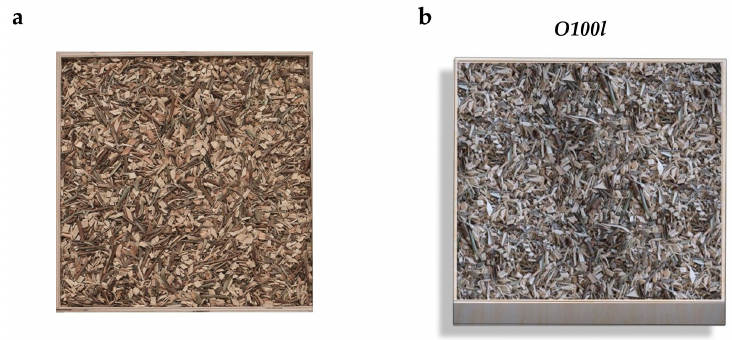
Figure 2. ( a ) Photo of the sample; ( b ) 3D image of a frame containing loose chips.